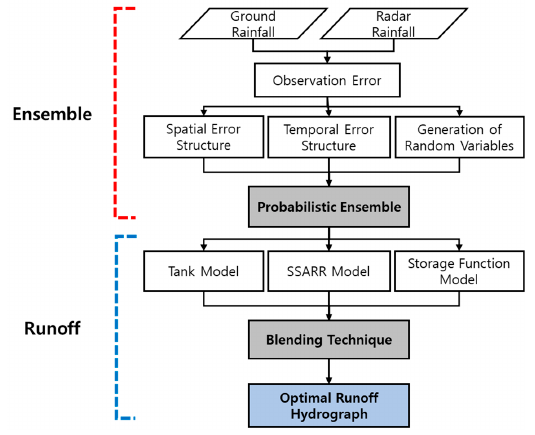
Figure 1. Diagram of the study.